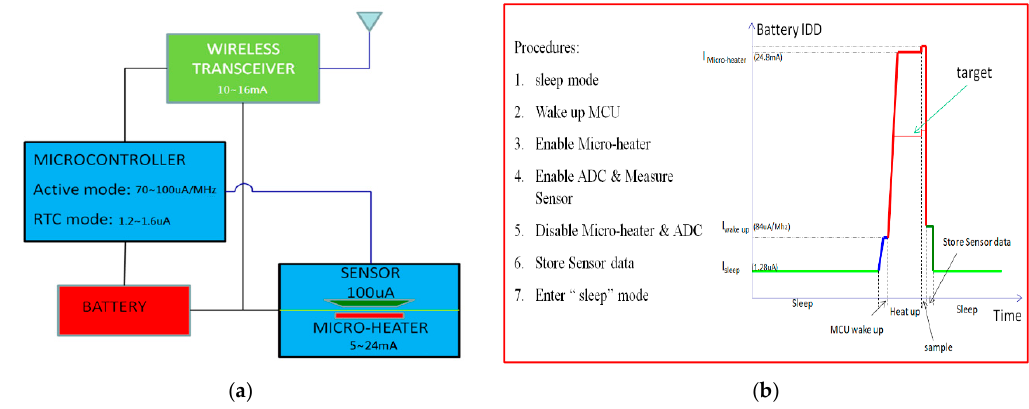
Figure 1. ( a ) Basic block diagram of IoT sensor network and ( b ) operating procedure for IoT sensor network.